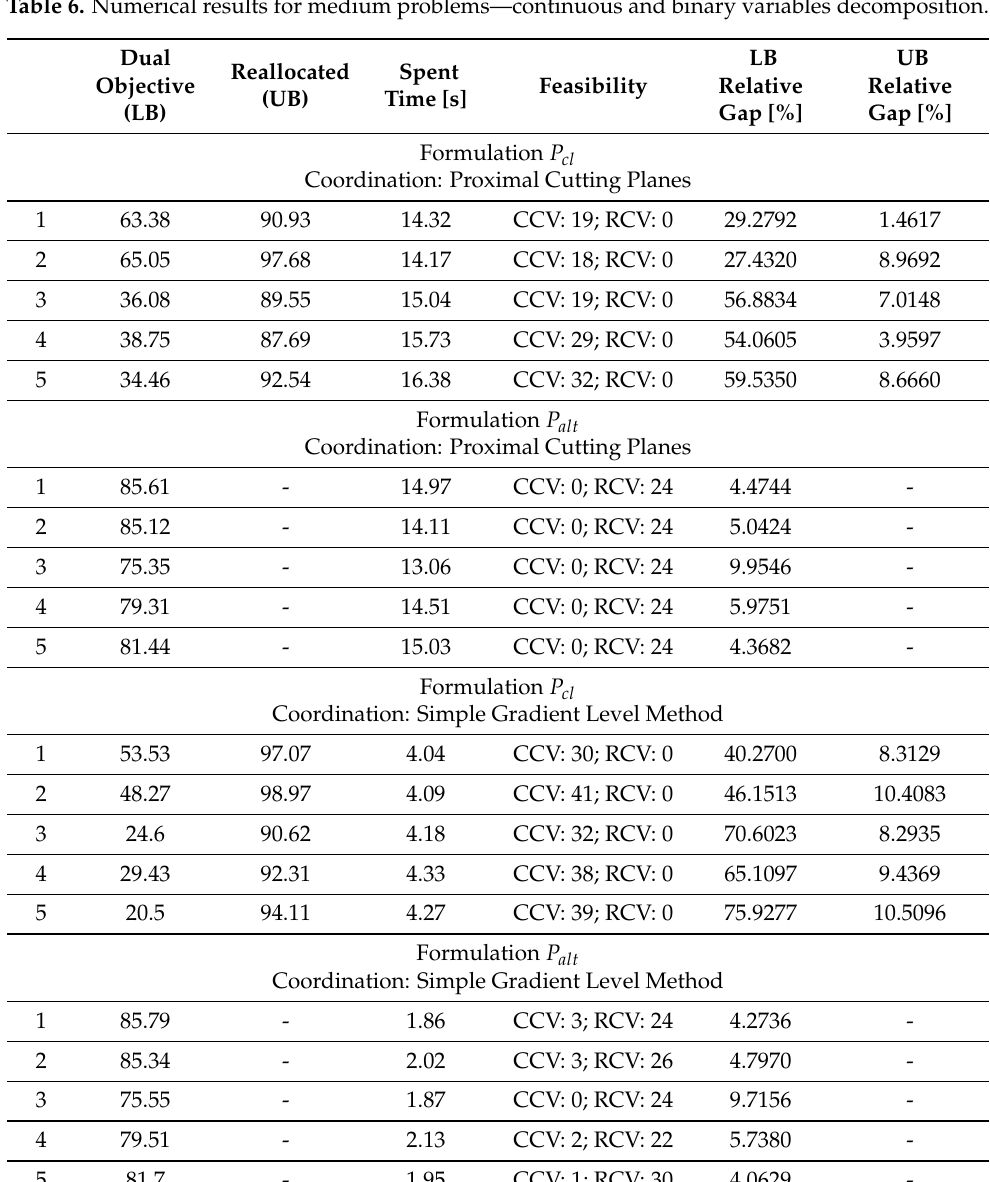
Table 6. Numerical results for medium problems—continuous and binary variables